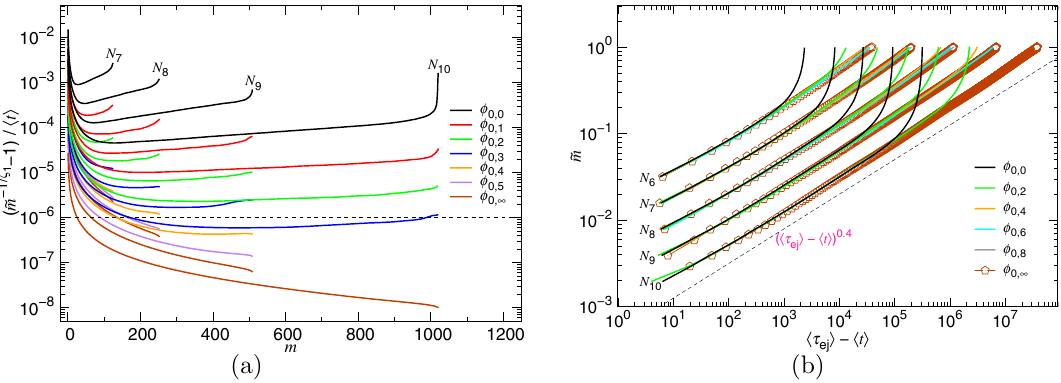
τ ej m vs. t . The φ 0 value can be read from ˜ � � − � �